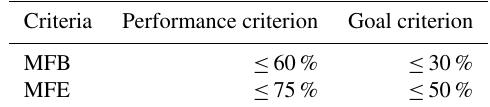
Table C2. Boylan and Russel